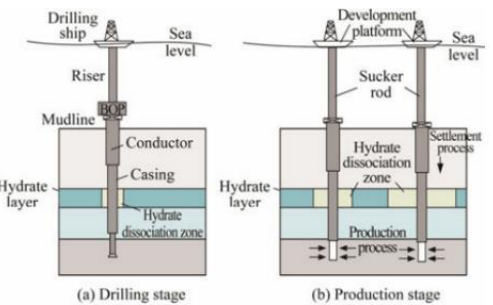
Figure 11. Sketch of wellhead instability caused by hydrate dissociation during the OGD process in deep water [This figure was modified with permission from ref. [160]. Copyright 2018, Springer].